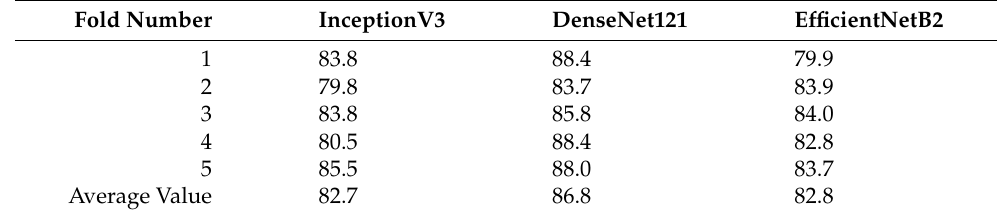
Table 9. Validation accuracy of single Chinese character binary classification of backing class.